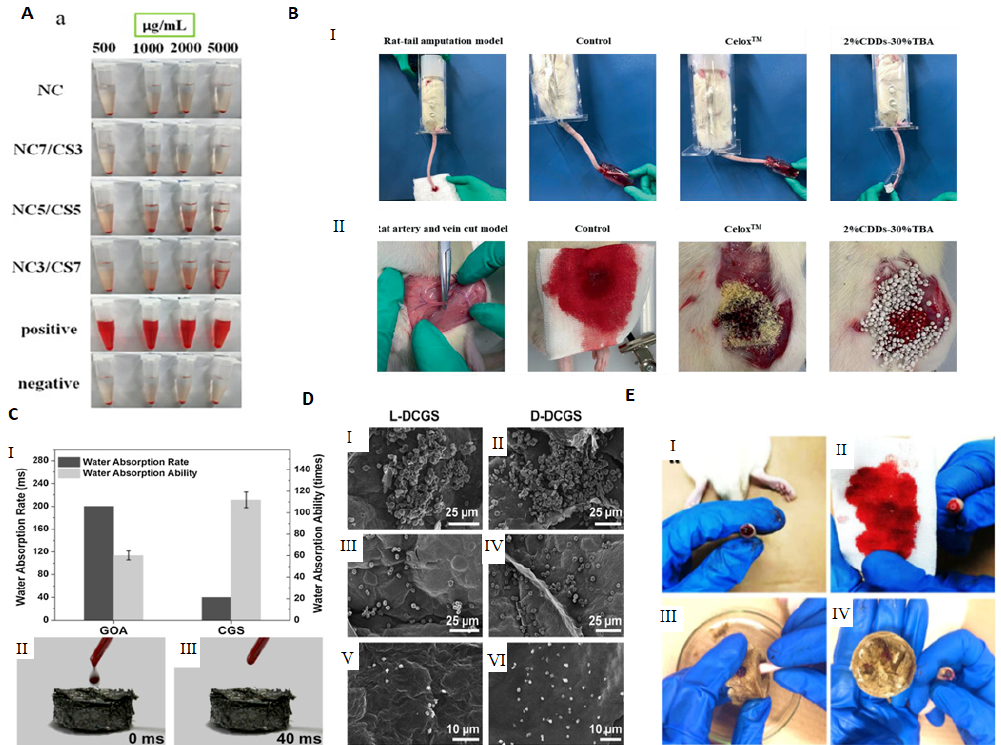
Figure 5. Use of bioaerogels in the treatment of wounds at the hemostasis stage: ( A ) photographs from hemolytic activity assay of the NC, NC7/CS3, NC5/CS5 and NC3/CS7 aerogels using sterile saline as negative control and deionized water as positive control. Notation: NC5/CS5 aerogel with 50 wt.% content of chitosan and cellulose nanofibers. Reprinted from ref [70], with permission from Elsevier. ( B ) In vivo hemostatic ability test and blood loss in the rat tail amputation model among the control, commercial product Celox, and chitosan/diatom-biosilica aerogel: ( I ) photographs of hemostatic effect and ( II ) blood loss in the rat tail amputation model. Adapted from ref [127] with permission from John Wiley and Sons. ( C ) ( I ) Water absorption rate and capability of cross-linked graphene sponge (CGS) and GO aerogel (GOA); ( II ) and ( III ) photographs of the blood absorption process on the CGS sample. Reprinted from ref [122], with permission from Elsevier. ( D ) ( I , II ) Images of cell morphology test of 2,3-Diaminopropionic acid cross-linked graphene sponge DCGS; ( III , IV ) hemocyte selective adhesion test; ( V , VI ) platelet selective adhesion test. Reprinted with permission from ref [125]. Copyright 2016 American Chemical Society. ( E ) Evaluation of the hemostatic performance of the bletilla striata polysaccharide/graphene oxide composite sponge (BGCS): ( I ) cutting the tail of the rat and bleeding; ( II ) 10 min application of gauze sponge resulted in continued bleeding; ( III ) BGCS was pressed on the wound; ( IV ) hemostasis was achieved by the BGCS. Reprinted from ref [128] with permission from